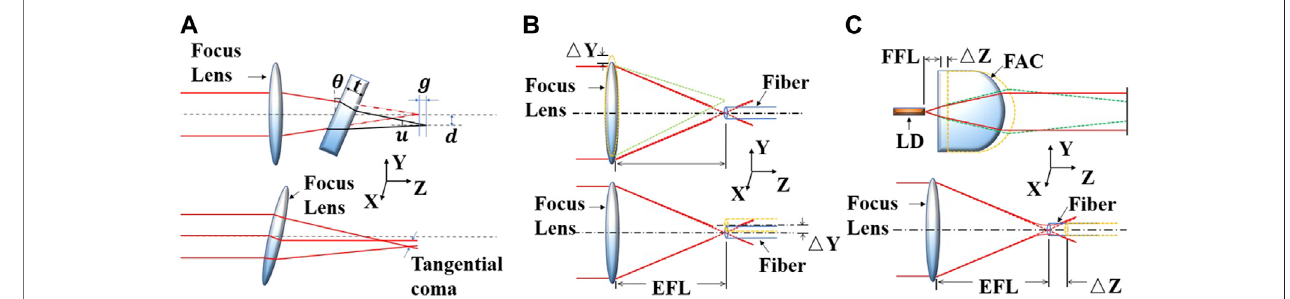
FIGURE 7 | Types of optical components misalignment: (A) Tilt; (B) Decenter; (C)